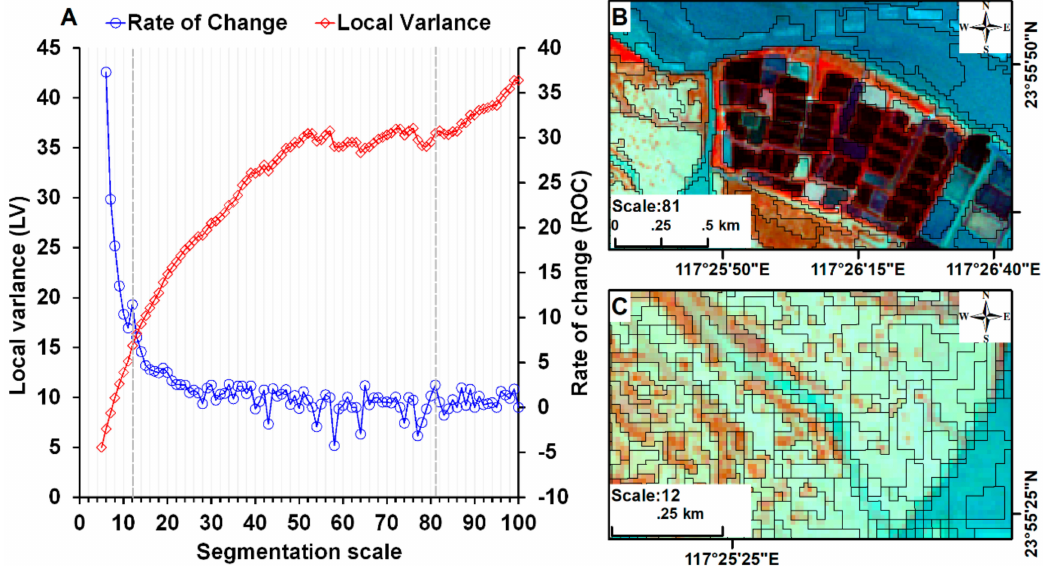
Figure 3. The optimal segmentation scales for di ff erent objects. ( A ) Changes in local variance (LV) and rate of change (ROC) with increasing segmentation scale. ( B ) Segmentation e ff ects with scale parameter of 81. ( C ) Segmentation e ff ects with scale parameter of